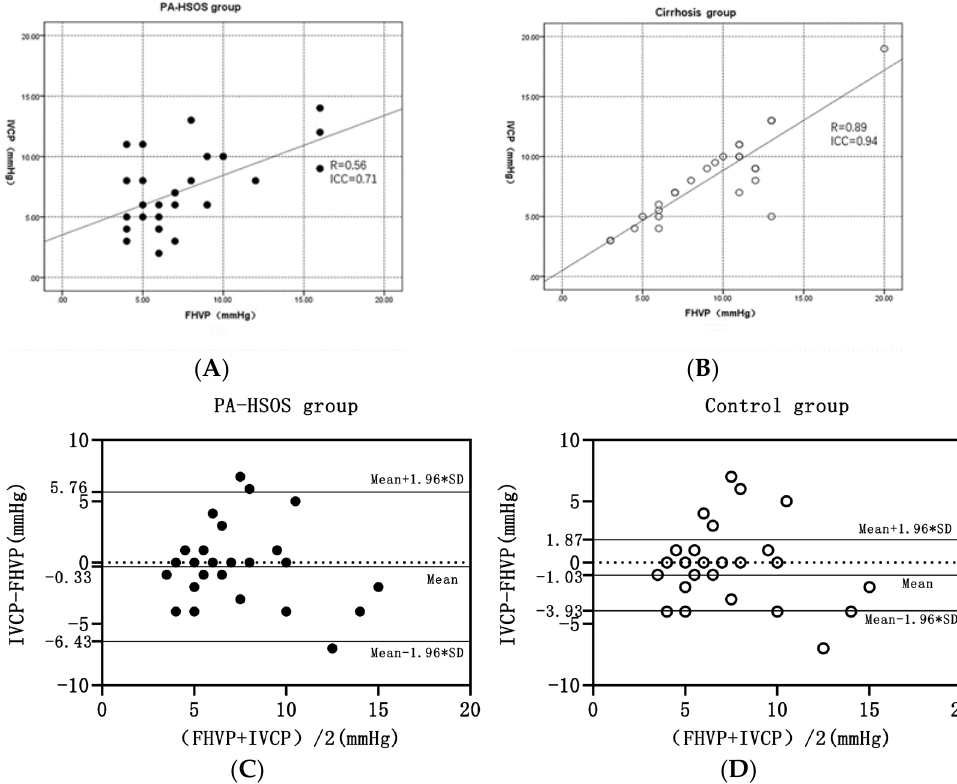
Figure 2. Correlation between FHVP and IVCP according to the scatter plot and the Altman and Bland plot. ( A ). In the patients with PA-HSOS ( n = 30), the strength of the linear correlation between FHVP and IVCP was moderate (R: 0.56; ICC: 0.71). ( B ). In the patients with cirrhosis ( n = 34), the strength of the linear correlation between WHVP and PP was excellent (R: 0.89; ICC: 0.94). ( C ). In the PA-HSOS group ( n = 30), three points were not within 95% of the mean difference between WHVP and PP, which ranged from −6 .43 to 5.76 mmHg. ( D ). In the cirrhosis group ( n = 34), nine points were not within 95% of the mean difference between WHVP and PP, which ranged from −3 .93 to 1.87 mmHg.